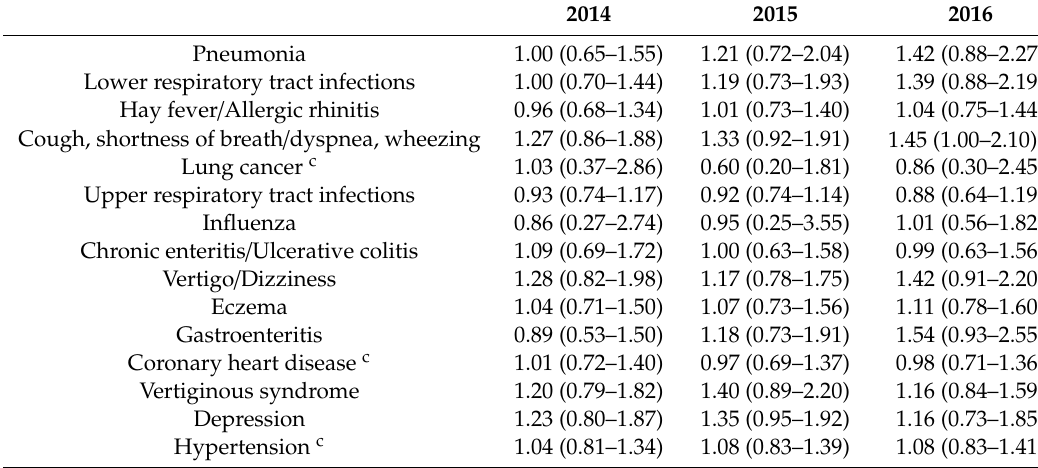
Table 3. Di ff erences (OR, 99% CI) a per year in various comorbid conditions between livestock dense areas and control areas among asthma patients b without comorbid COPD.